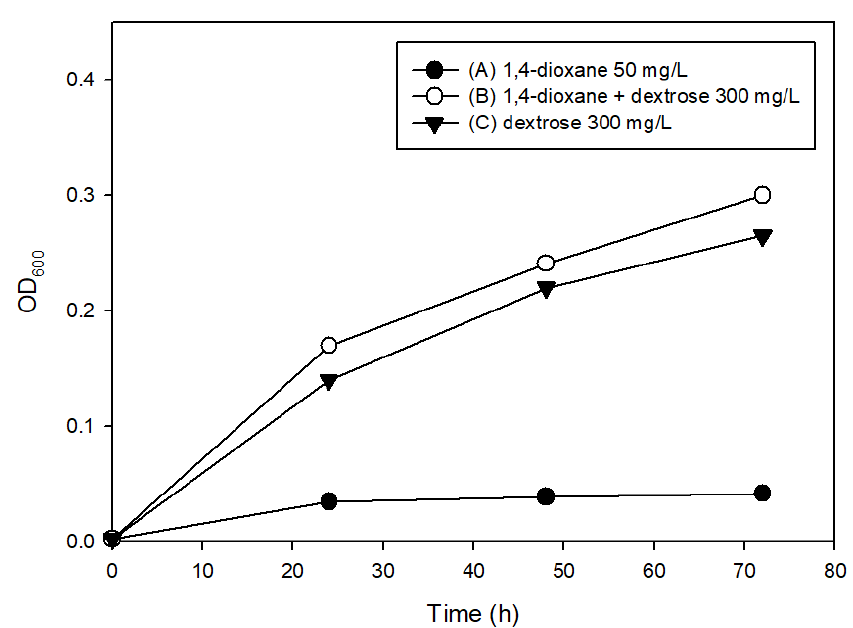
Figure 5. Cell growth of the mixed culture with different combinations of 1,4-dioxane and dextrose monitered by OD 600 .